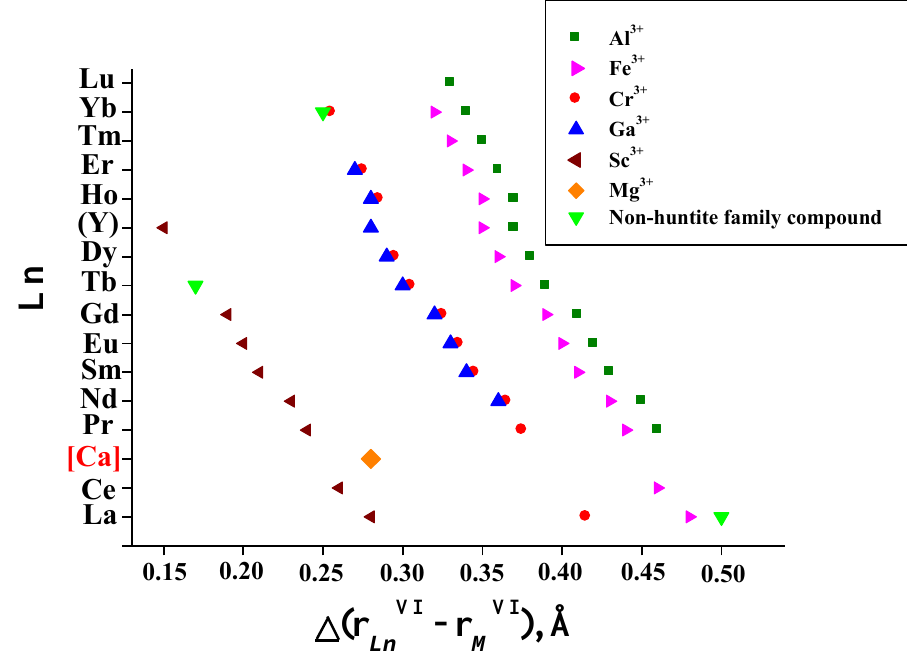
Figure 11. The stability region for the phases with the general composition LnM 3 (BO 3 ) 4 with the M 3+ = Al, Fe, Cr, Ga, Sc given as correlation between the type of Ln ion and the difference between the ionic radii of Ln and M ions.